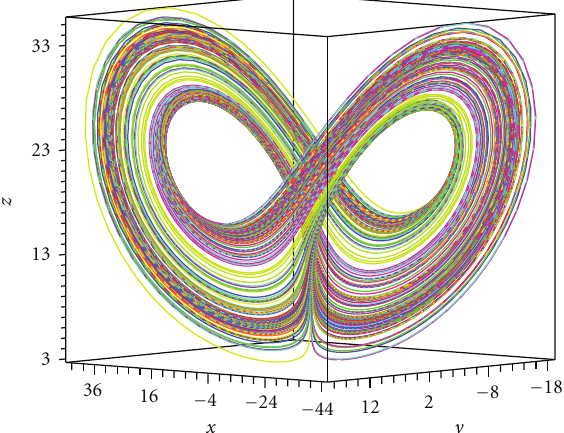
of the 𝑏𝑏 F 5: Projection of the new system (2) on the